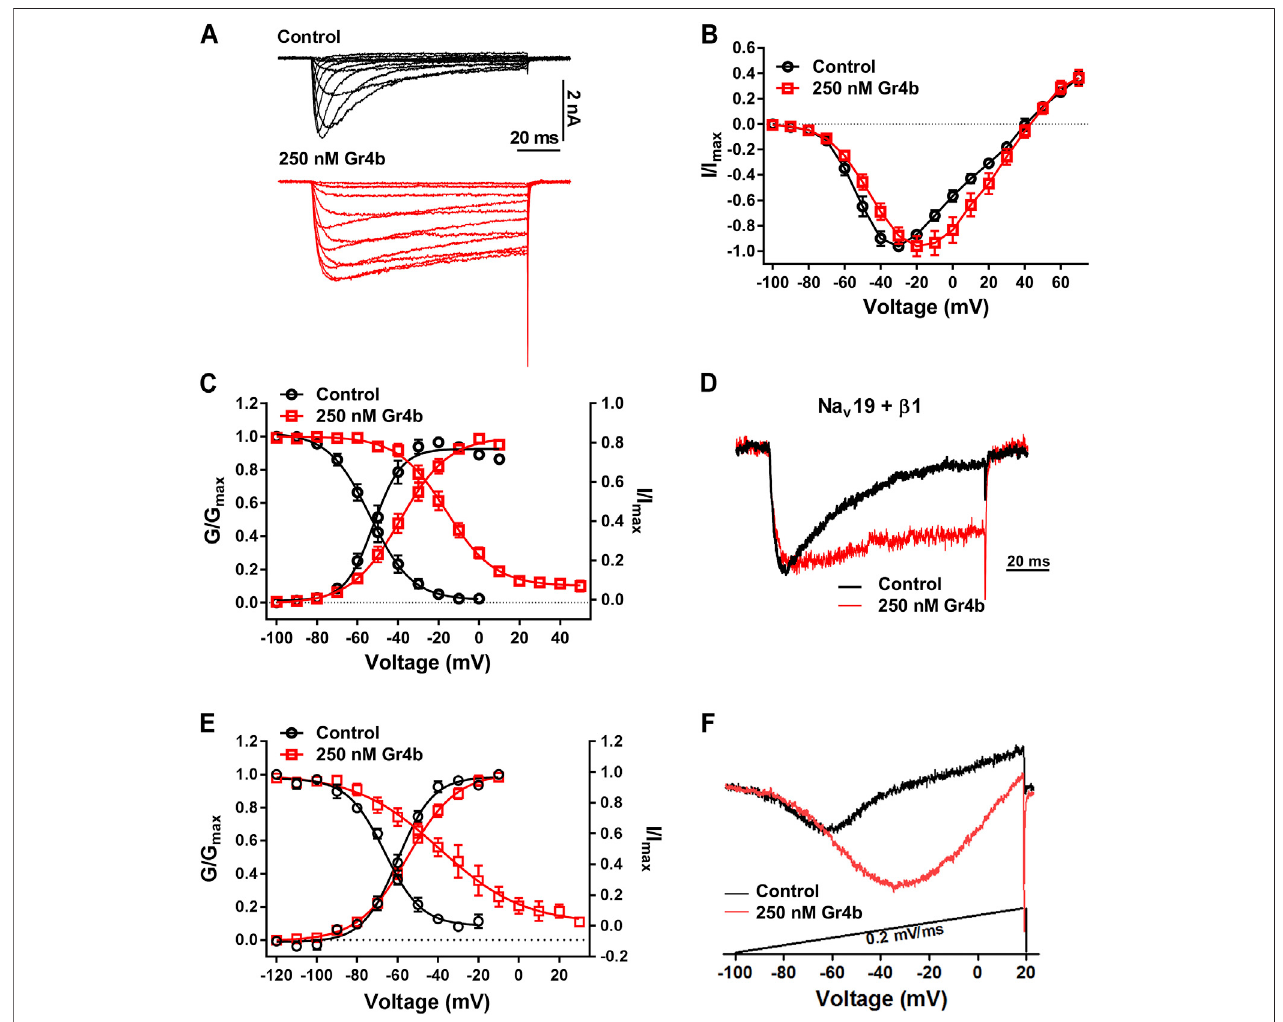
FIGURE 3 | EffectofGr4bonactivationand inactivationofNa v 1.9. (A) Representativecurrent tracesofNa v 1.9 testedbydifferent voltages, inthe absence (black) and presence of 250 nM Gr4b (red). (B) Current-voltage (I – V) curves for the Na v 1.9 channel in the absence (black) or presence (red) of 250 nM Gr4b (n (cid:2) 8). (C) Voltage- dependentsteady-stateactivation(G/G max ,n (cid:2) 8)andfastinactivation(I/I max ,n (cid:2) 6)ofNa v 1.9intheabsence(black)orpresence(red)of250 nMGr4b.Currentswereelicited byaclusterofdepolarizationsfrom − 100 mVto+70 mV(in10 mVincrements)fromtheholdingpotentialof − 120 mVfor50 ms.Forsimplicity,onlypartofthecurrents wereshown.The voltage dependence ofsteady-stateinactivationwas estimated byusing a standarddouble-pulseprotocol, inwhich a 50 msdepolarizing testpotentialto − 30 mVfolloweda500 msprepulse(rangedfrom − 120 mVto+50 mV,in10 mVincrement). (D) RepresentativecurrenttracesshowingthatGr4bslowedthefastinactivation of Na v 1.9 co-expressed with β 1 in ND7/23 cells. The currents evoked by 100 ms depolarization to − 40 mV from holding potentials of − 120 mV. (E) Voltage-dependent steady-state activation (G/G max , n (cid:2) 5) and fast inactivation (I/I max , n (cid:2) 6) of Na v 1.9 co-expressed with β 1 in the absence (black) or presence (red) of 250 nM Gr4b. (F) Compared with control treatment, 250 nM Gr4b signi fi cantly enhances the ramp currents of Na v 1.9 channels expressed in ND7/23 cells.